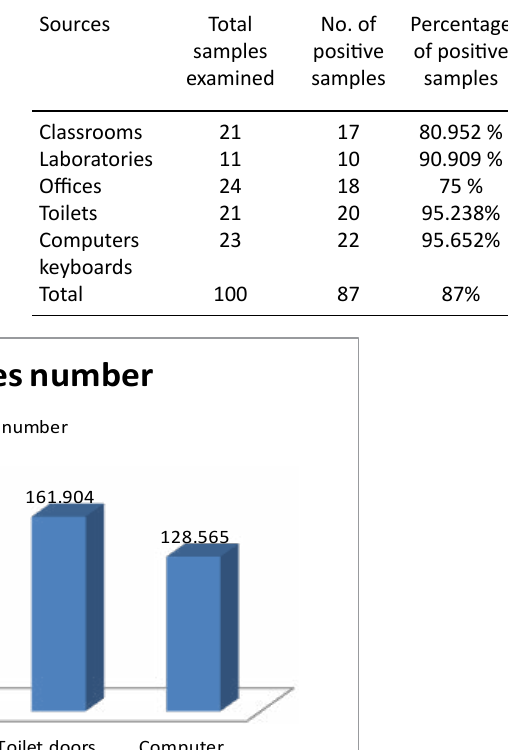
Figure (1): Bacterial contamination load Gram stain differentiation showed 65% of samples gives were gram positive and 35% were gram negative.